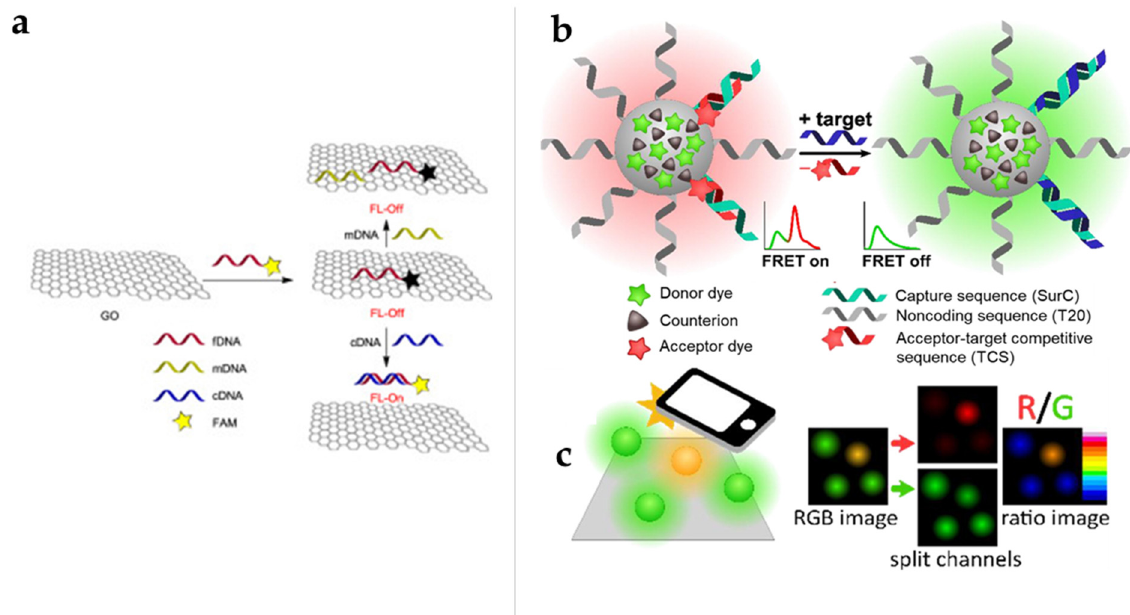
Figure 2. DNA target biosensor using nanomaterial-based FRET. ( a ) Schematic representation of the detection of a deletion mutation in exon 19 of the EFGR gene on a graphene oxide surface [68]. ( b ) Schematic diagram of the FRET-based RGB detection of DNA as a cancer biomarker by using a smartphone. This figure is reproduced from [64] (© 2016 Elsevier B.V.); Green emission from the nanoprobe (NP) surface transfers some of the excitation energy to the FRET receptor on the NP surface and, thereby, causes the NP to fluoresce in yellow–orange. ( c ) Smartphone-based data analysis. Green and red RGB images are taken, and intensity ratios between the channels are evaluated. This figure is reproduced from [66] (© 2020 Elsevier B.V.).